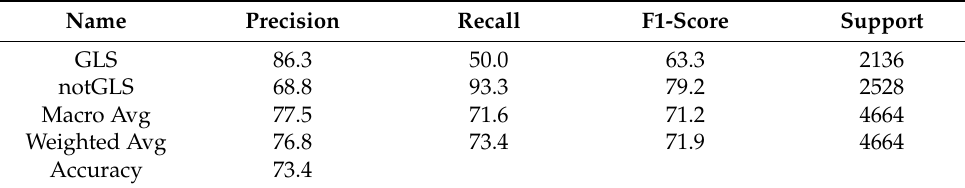
Table 5. Performance of GLS_net upon the IF testing set.